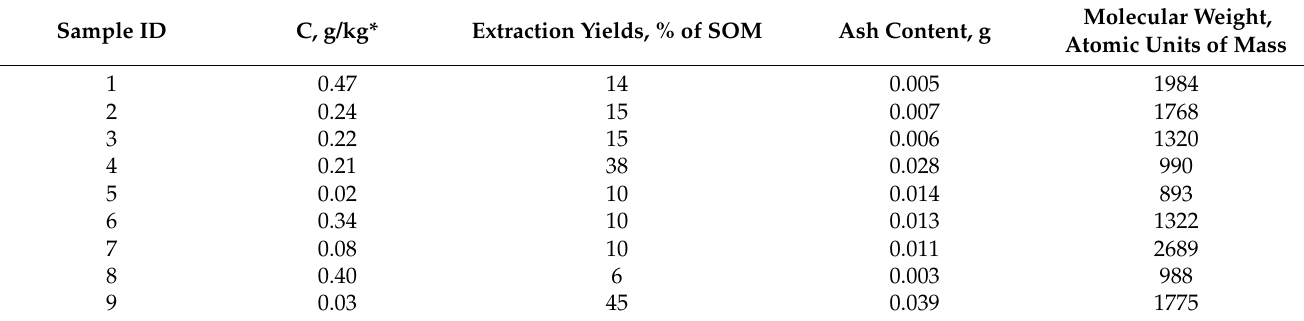
Table 2. The extraction data of HAs. Sample ID corresponds to Table